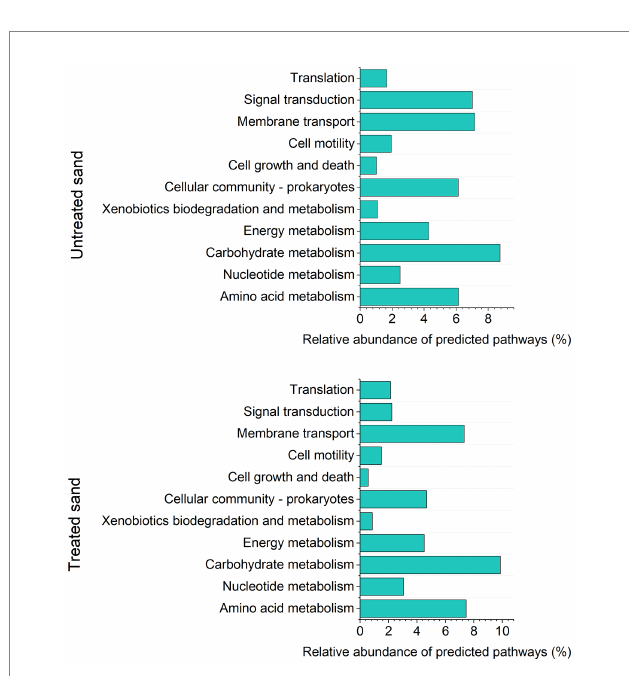
FIGURE 5 Analysis of predicted KEGG metabolic pathways at level 2, based on Tax4fun2: (A) Relative abundance of predicted pathways in sessile community from untreated sand. (B) Relative abundance of predicted pathways in sessile community from treated sand.